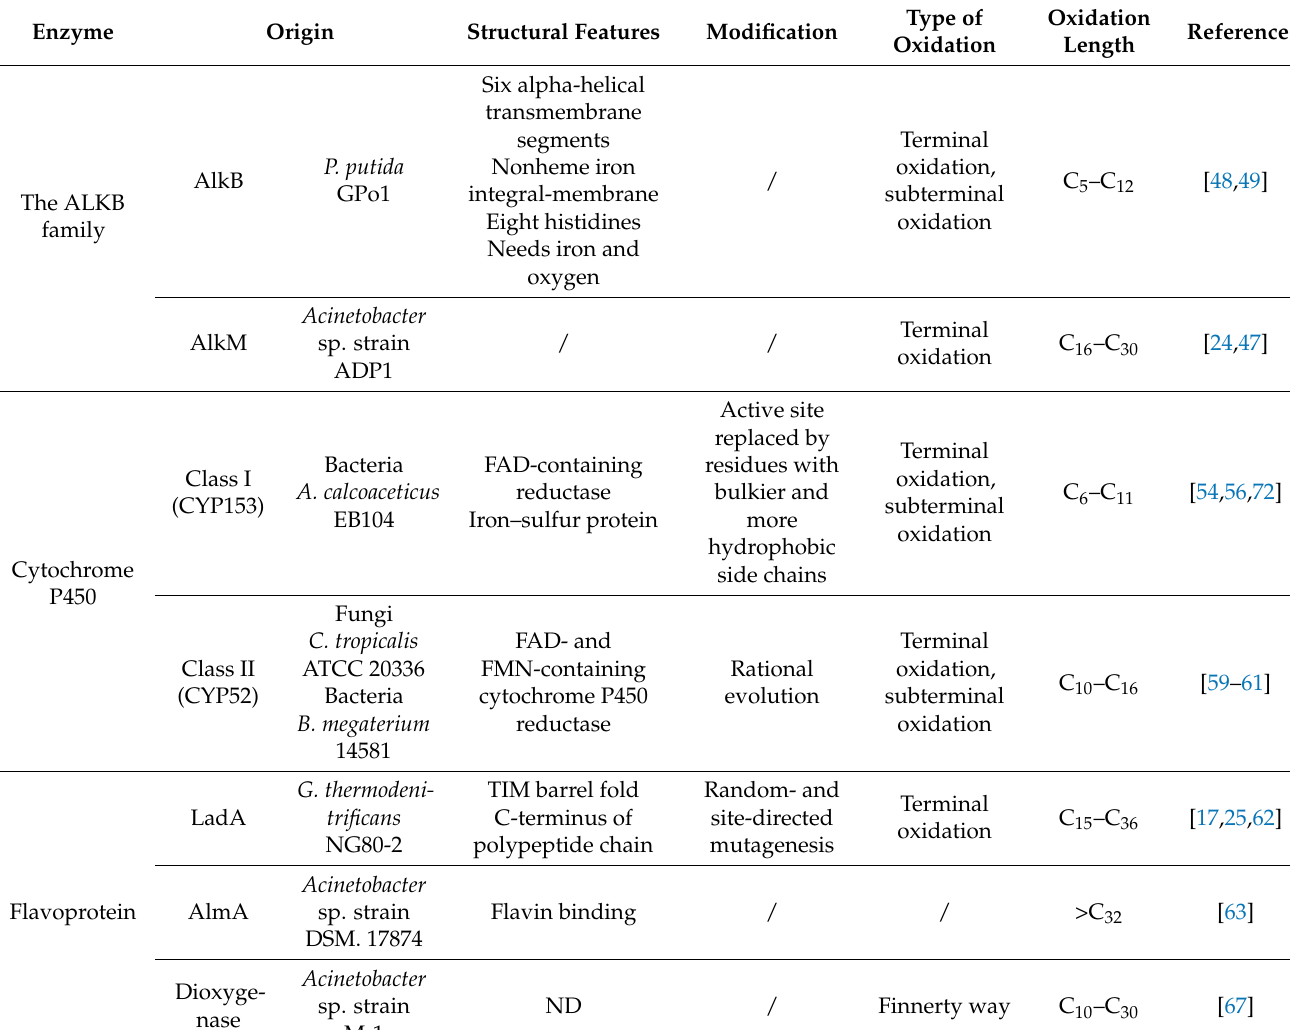
Table 1. Some important alkane